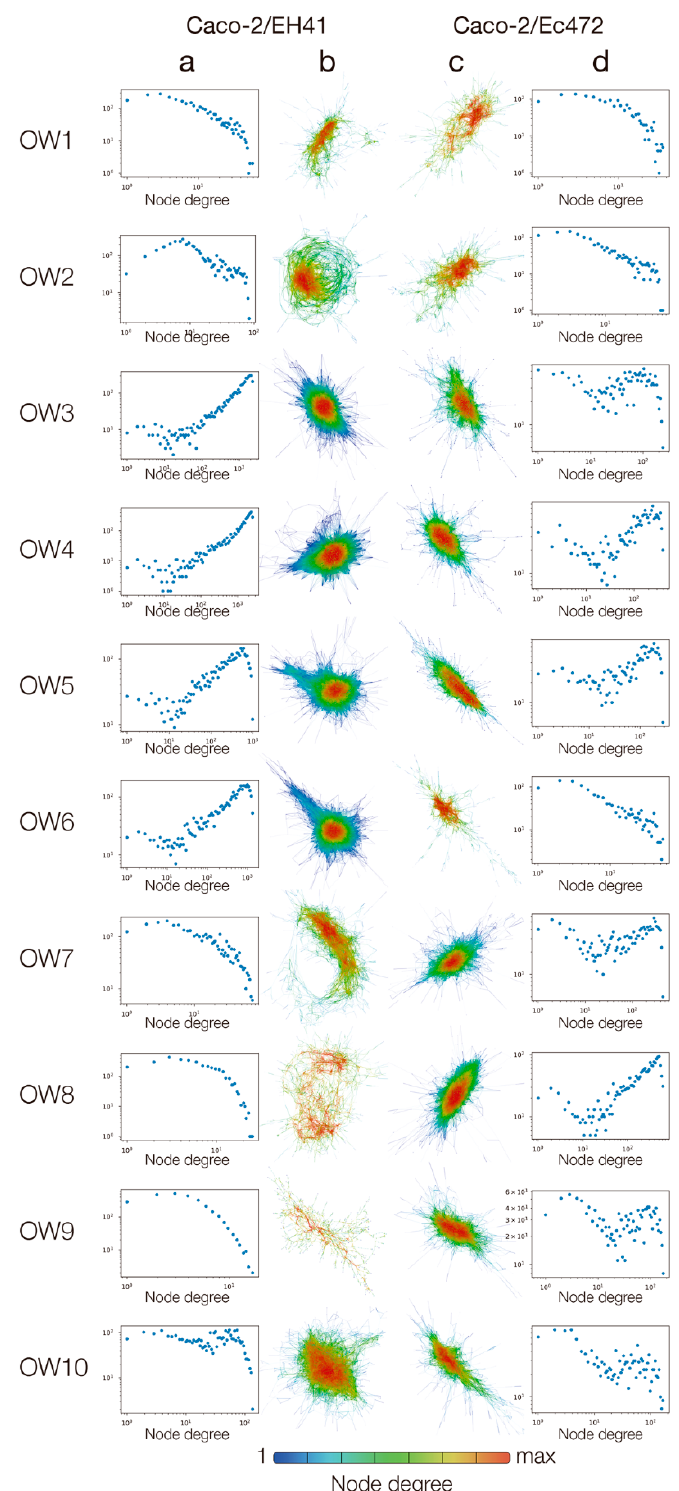
Figure 4. Dynamic DE networks of Caco-2 cells along three hours of enterocyte–STEC interaction. Node degree distributions and gene co-expression networks for Caco-2 / EH41 ( a , b ) and Caco-2 / Ec472 ( c , d ) groups in 10 overlapping windows (OW1–10). In the Caco-2 / EH41 group, anomalous degree distributions appear in OW3–OW6, recovery from this regime occurs in OW7–OW9, and the anomalous status is regained in OW-10. In Caco-2 / EH472, only the networks for OW1 and OW2 display a regular degree distribution.